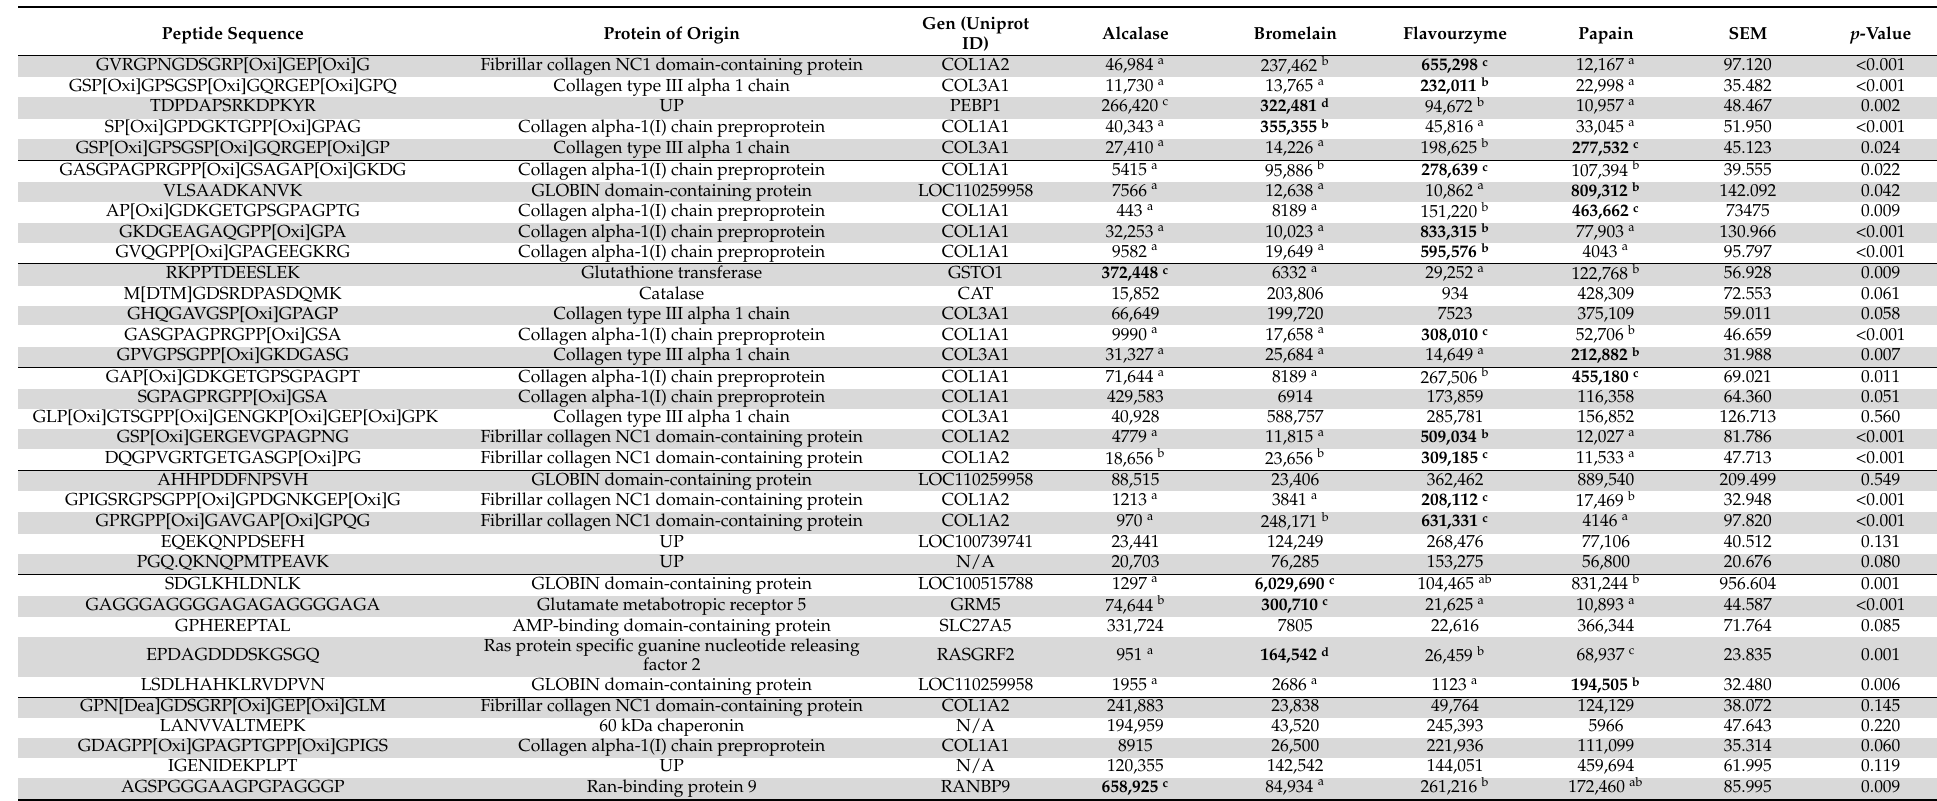
Table 3. Pork liver peptides identified and quantified by LC-MS/MS from hydrolysis treatment with different enzymes (alcalase, bromelain, flavourzyme, and